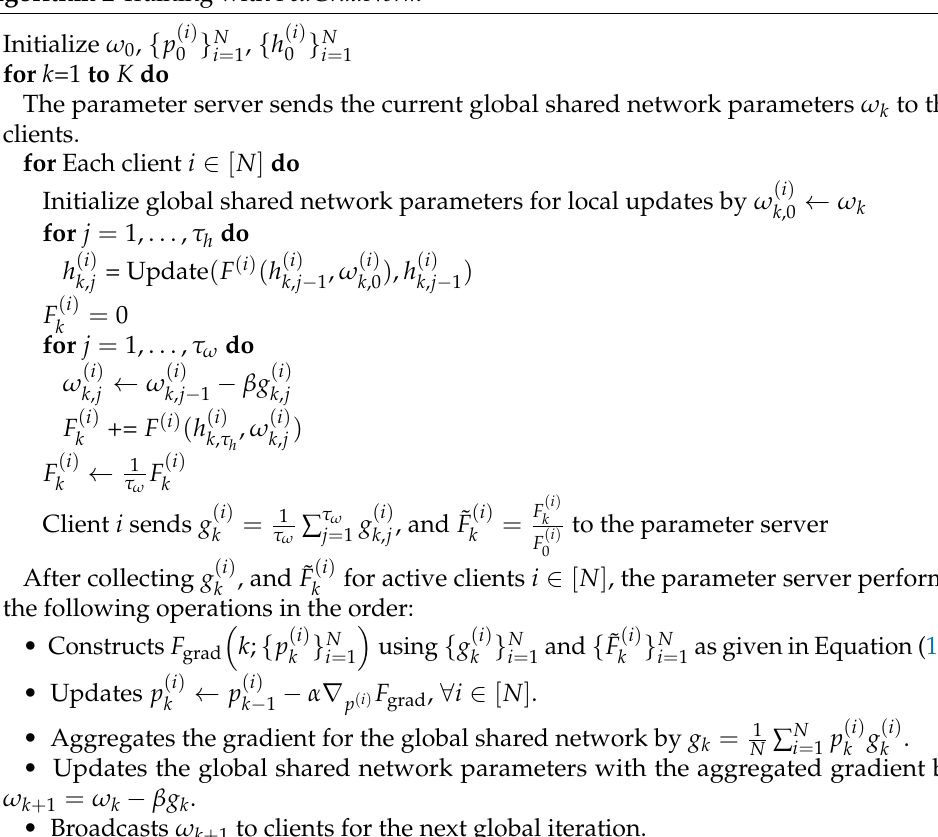
Algorithm 2 Training with